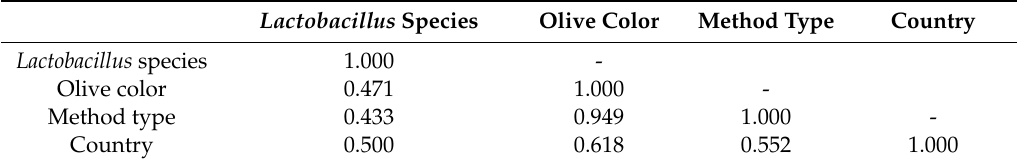
Table 4. Cramer’s V correlations matrix for the LAB, olive color, method type, and country variables. Lactobacillus Species Olive Color Method Type